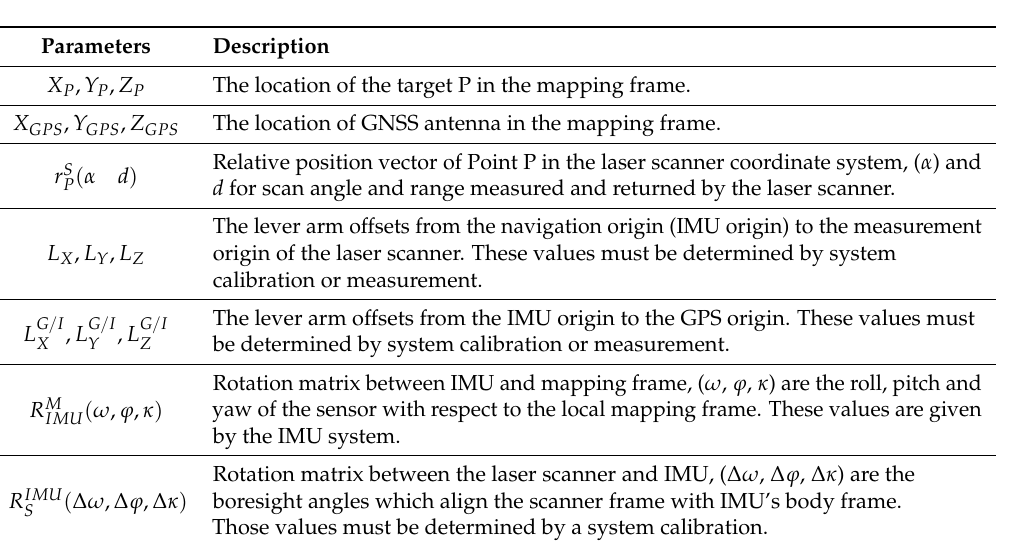
Table 2. Parameters of the geo-referenced equation.